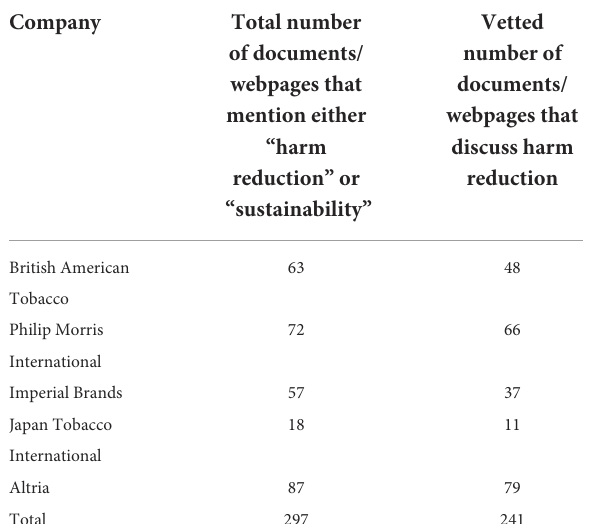
TABLE 1 Number of documents and webpages discussing harm reduction.